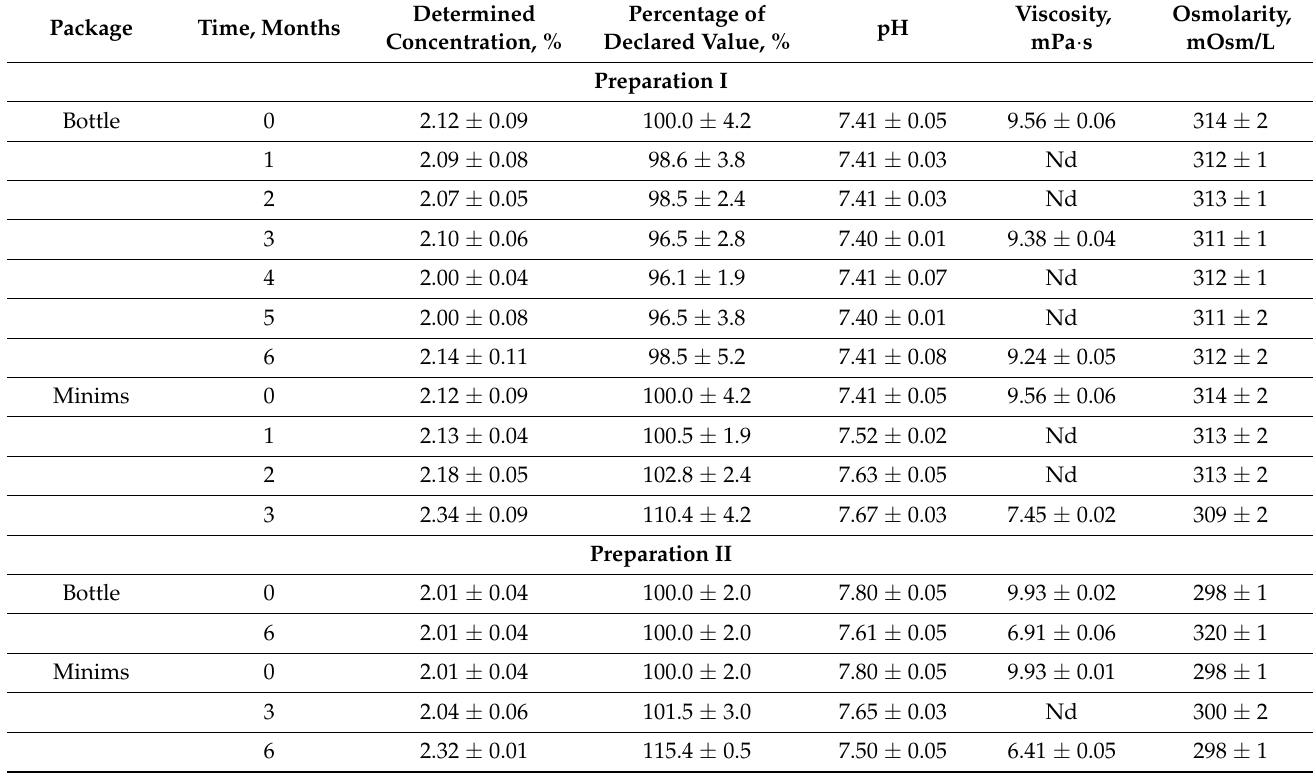
Table 3. Stability of choline salicylate eye drops formulated using Preparations I and II stored under controlled conditions (40 ◦ C/75% RH) in bottles and minims—results of CS determinations by HPLC and measurement of pH, viscosity, and osmolarity (mean ± SD, n = 3).